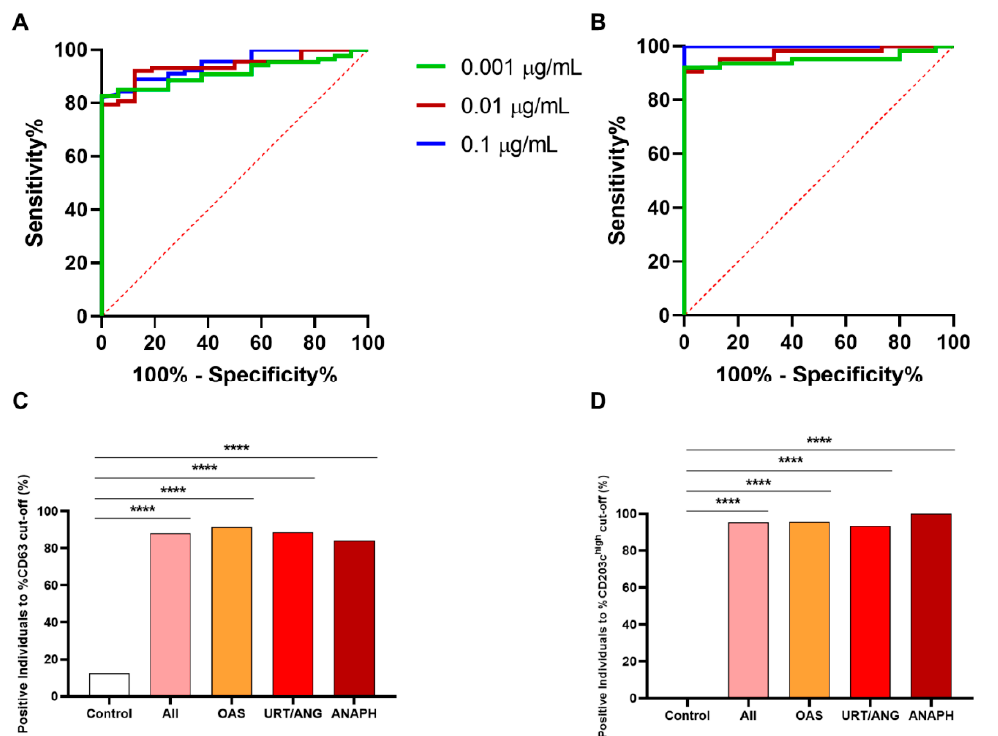
Figure 8. ROC curve analysis for BAT in predicting peach allergy. ROC curves of %CD63 + ( A ) and %CD203c high ( B ) were performed at the three selected concentrations of Pru p 3 (0.1, 0.01, and 0.001 µ g/mL). The positivity of patients to BAT were calculated using optimal cut-off values from %CD63 + ( C ) and %CD203c high ( D ), not showing any differences between the severity group, but these groups and the whole allergic patients had a significantly higher percentage of positivity in comparison to healthy controls. **** p < 0.0001. ANAPH, anaphylaxis; OAS, oral allergy syndrome; URT/ANG, urticaria/angioedema.